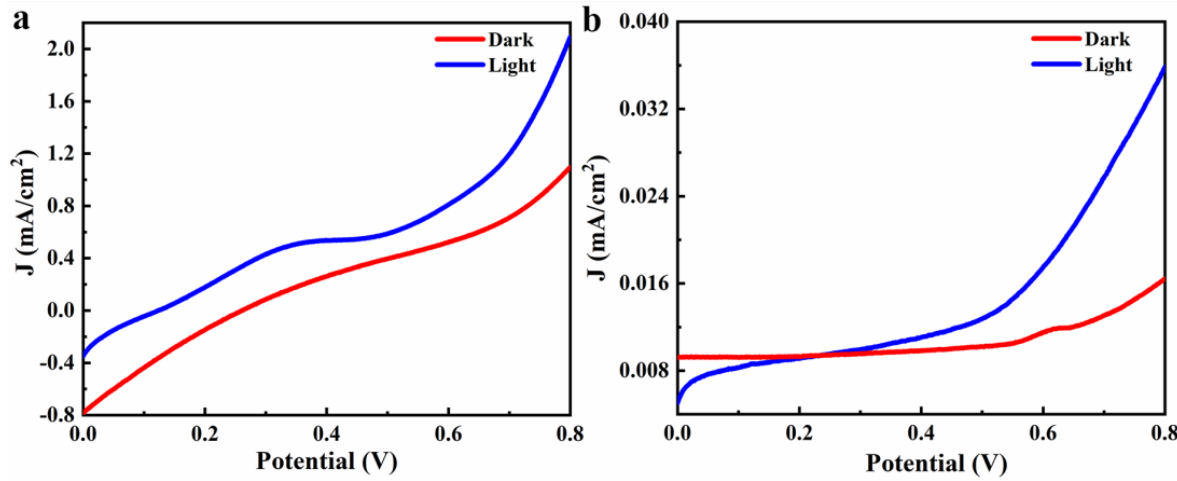
Figure 8. ( a ) J–V curves of the photocatalytic devices prepared by PLD technology; ( b ) J–V curves of the device obtained by Figure 8. ( a ) J – V curves of the photocatalytic devices prepared by PLD technology; ( b ) J – V curves of the device obtained replacing the perovskite layer with CsPbBr3 quantum by replacing the perovskite layer with CsPbBr3 quantum electricity.